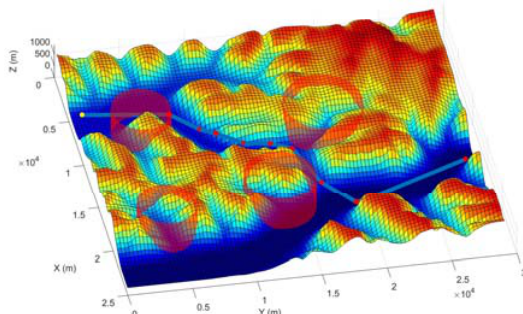
Fig. 8. UAV trajectory computed by the FPA in Russia, East of Norilsk (Top-left corner is 69.2464N 91.1934E, 716 km 2 , terrain elevation from 40 to 1,382 m AMSL)